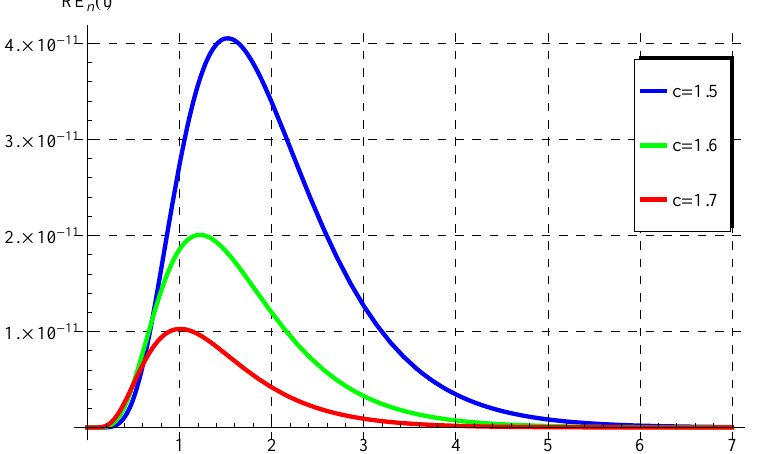
Figure 10. The residuals RE r ( t ) , r = 10,11,12,13 in Equation (76) at various values of c ( c > 1) when λ = 1, a = − 1, and b = 1 4